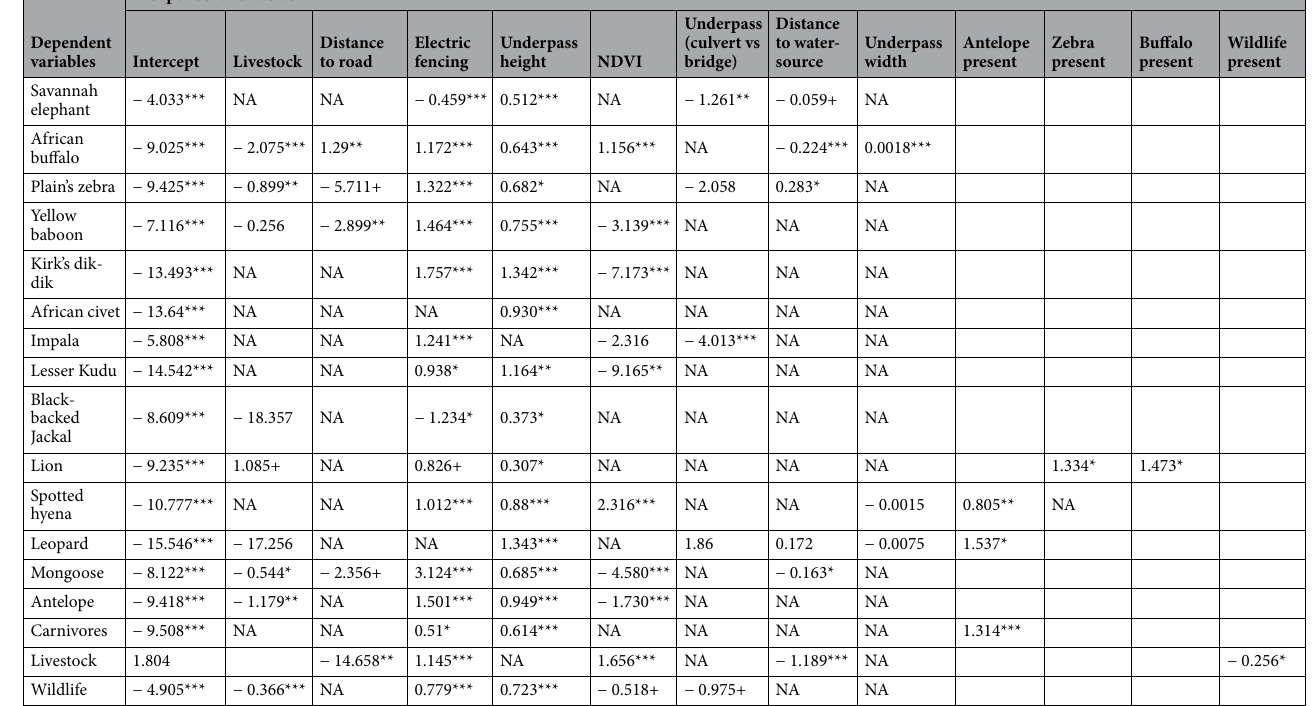
Table 3. Coefficients from the best of several models for each mammalian species or group based on AIC showing the influence of infrastructure design and ecological factors on Standard Gauge Railway underpasses use in Tsavo Conservation